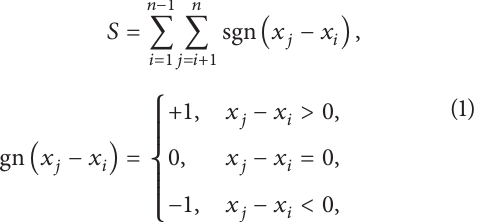
Precipitation (mm)